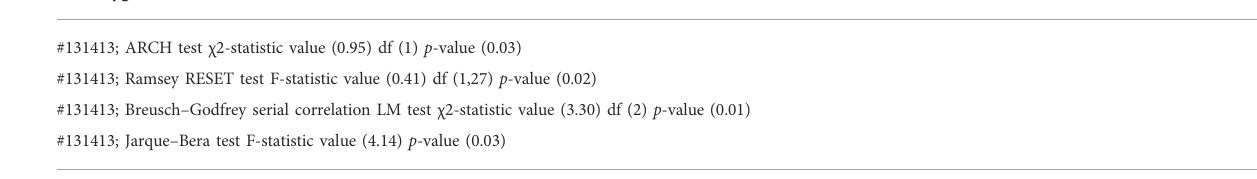
TABLE 6 Results of diagnostic tests.